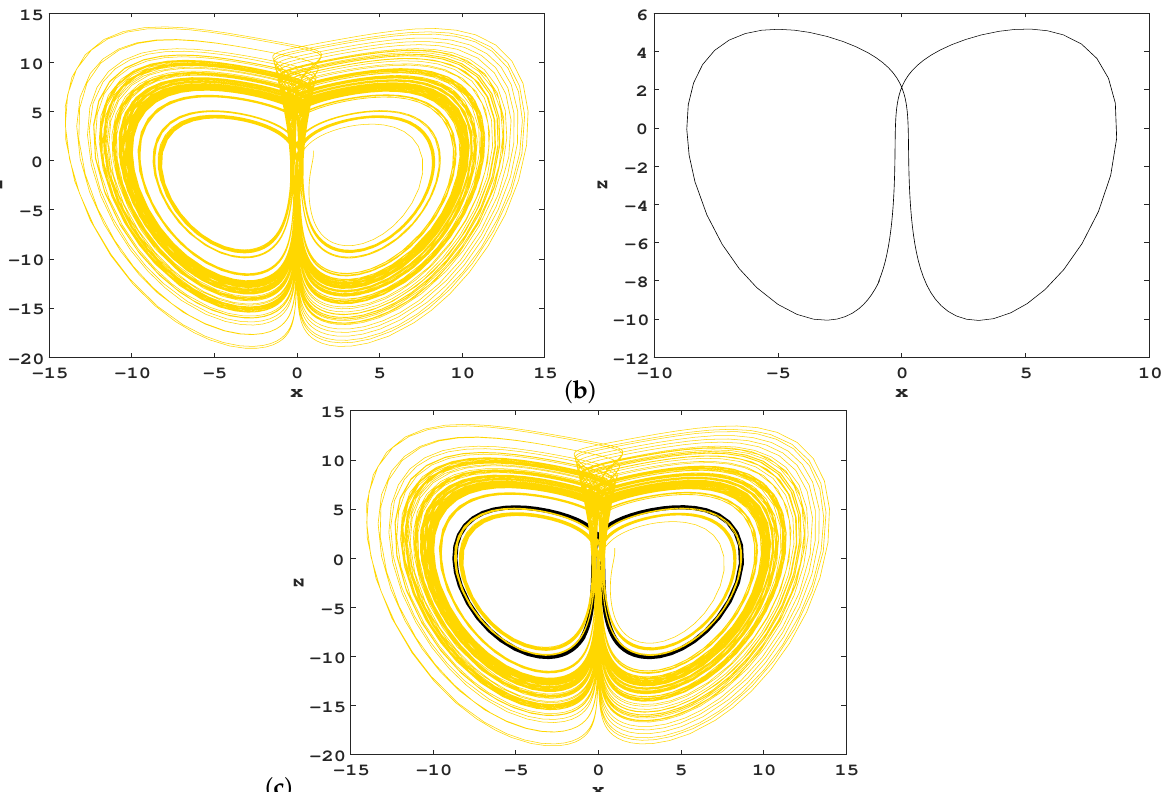
Figure 8. Two coexisting hidden attractors of system (2); ( a , b , c , k , m ) = ( 10,12,2.7, − 0.2,1 ) ; ( a ) chaotic attractor; ( b ) periodic attractor; ( c ) coexisting attractors. The yellow line represents chaotic attractor and the black line represents periodic